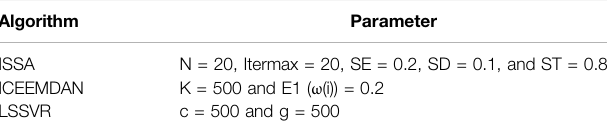
TABLE 4 | Parameter settings of the hybrid model. Algorithm